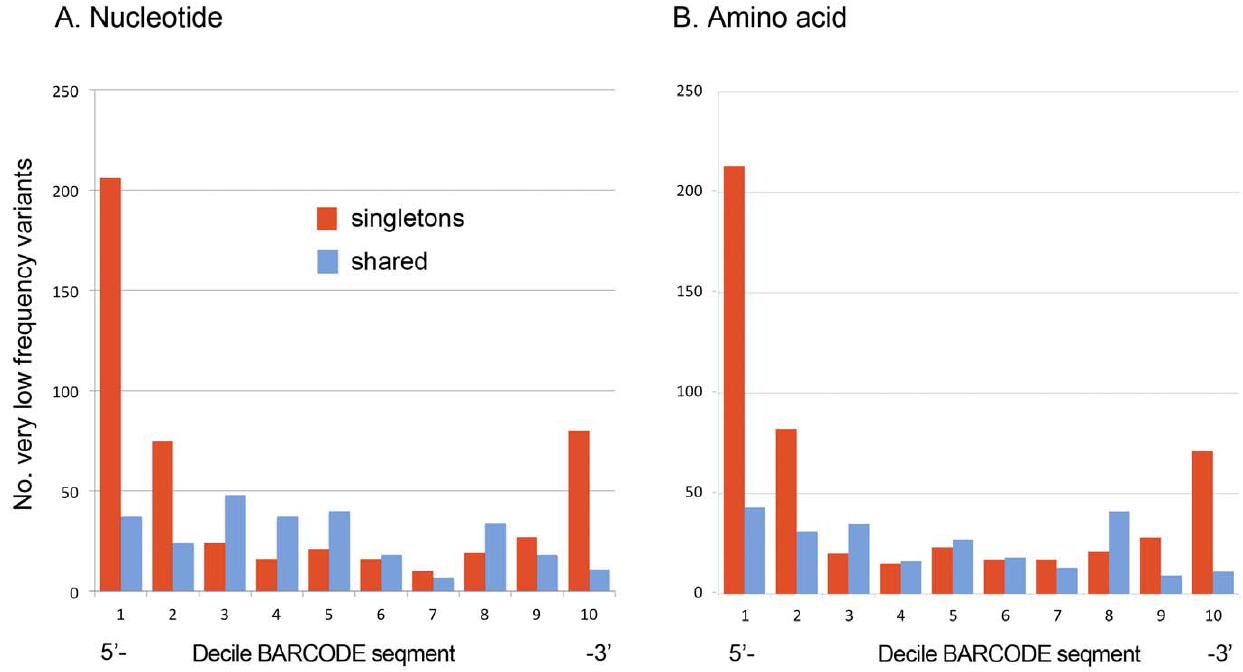
Figure 3. Distribution of very low frequency (VLF) variants across barcode segment. A) Nucleotide. B) Amino acid. doi:10.1371/journal.pone.0043992.g003 PLOS ONE |